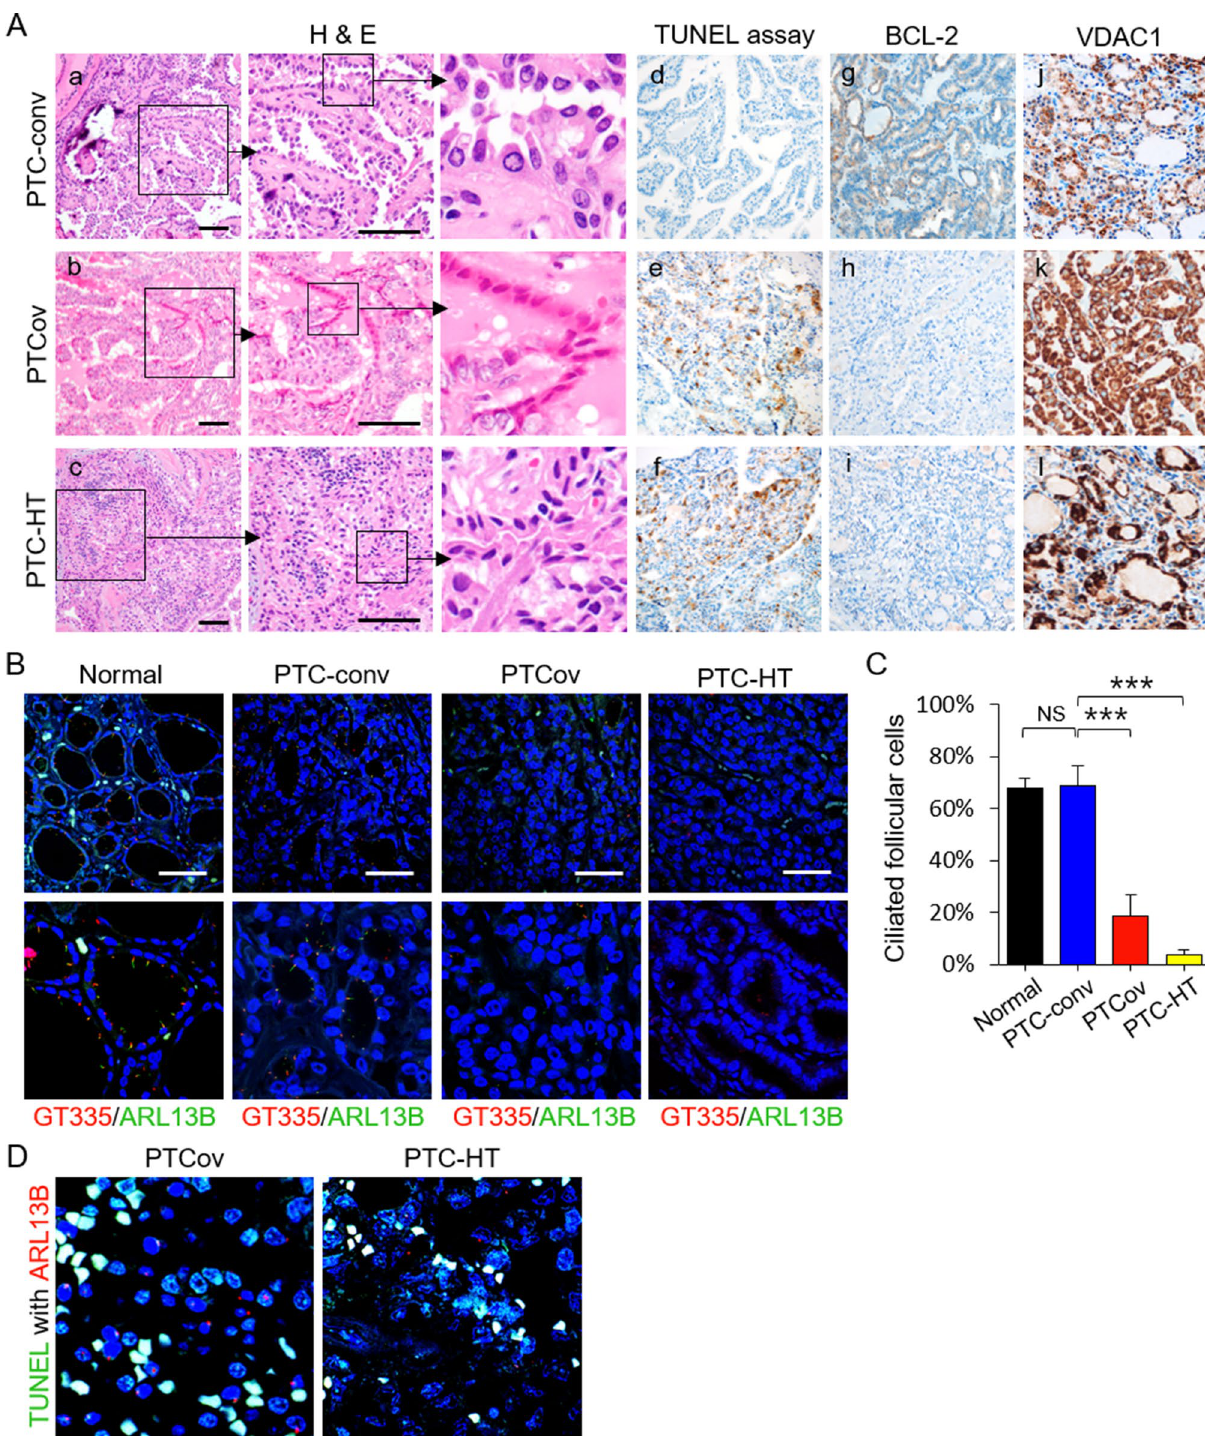
Figure 4. The proportion of apoptotic cancer cells increases in PTCs showing ciliary loss. ( A ) Upon histological examination after H & E staining, apoptotic cancer cells appeared dark, with an eosinophilic cytoplasm and dense purple nuclear chromatin fragments (insert). TUNEL analysis revealed significantly more apoptotic cancer cells in PTCov and PTC-HT tissues than in PTC-conv tissue (d, e, and f). BCL-2 expression levels were lower in PTCov and PTC-HT tissues than in PTC-conv tissue (g, h, and i). Immunoexpression of VDAC1 was higher in PTCov and PTC-HT than in PTC-conv (j, k, and l). Scale bar, 10 μm. ( B , C ) Immunofluorescence images show labeling of primary cilia in normal human thyroid follicles and PTCs by antibodies specific for GT335 and ARL13B. Fewer primary cilia were detected in oncocytic cancer cells in PTCov and PTC-HT tissue than in normal thyroid follicles or conventional PTC tissue. Scale bar, 10 μm. Abbreviations: PTC-conv, conventional papillary thyroid carcinoma; PTCov, oncocytic variant of PTC; PTC-HT, PTC with Hashimoto’s thyroiditis background. *** P < 0.001, NS; not significant. ( D ) TUNEL with ARL13B double immunofluorescence staining revealed that TUNEL-positive cancer cells (green) have no primary cilia (stained by ARL13B;